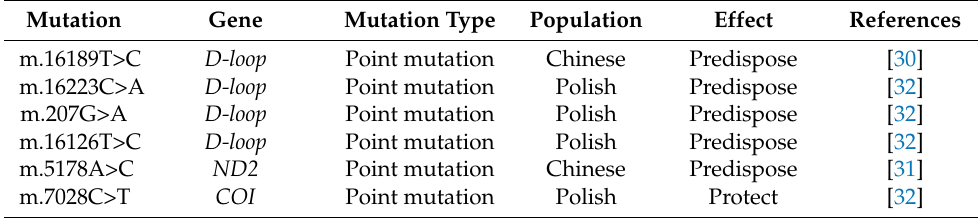
Table 1. Germline mitochondrial DNA mutations that may predispose or protect from endometrial cancer. Mutation